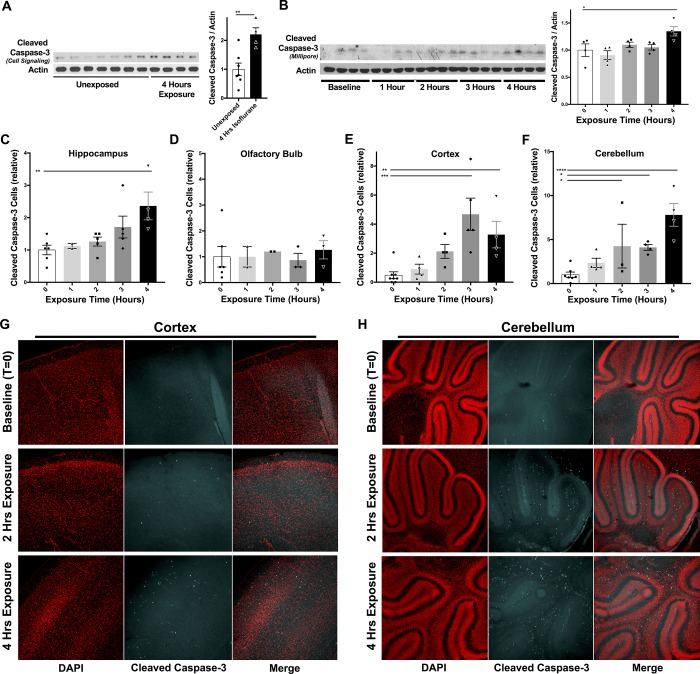
Anesthesia induced apoptosis in P7 neonatal mice.(A) Western blot probing for cleaved caspase-3 in brain lysates from control P7 mice (unexposed) and P7 mice exposed to 1.5% isoflurane for 4 hours. **p<0.005, pair-wise t-test. n = 7 and 4 for baseline and exposed, respectively. (B) Western blot probing for cleaved caspase-3 in brain lysates from P7 mice exposed to 1.5% isoflurane for 0 to 4 hours. ANOVA p-value<0.0008; **p<0.005, post-hoc pair-wise t-test. n = 4 at each timepoint. (C-F) Quantification of cleaved caspase-3 positive cells in the hippocampus (C), olfactory bulb (D), cortex (E), and cerebellum (F) of P7 neonatal mice exposed to 1.5% isoflurane for 0–4 hours. One-way ANOVA: hippocampus: *p<0.02; olfactory bulb: non-significant; cortex ***p = 0.0006; cerebellum *** p = 0.0007. In each panel *p<0.05, **p<0.005, ***p<0.0005 in post-hoc pair-wise t-tests. Error bars represent SEM. (G-H) Representative confocal images of immunofluorescent staining for cleaved caspase-3 in the cortex (G) or cerebellum (H) of animals exposed to 1.5% isoflurane for 0, 2, or 4 hours. The red channel represents DAPI, a fluorescent DNA binding molecule. The cyan channel represents the anti-cleaved Caspase-3 antibody directly conjugated to AlexaFluor647. Additional details regarding replicate numbers in cleaved caspase-3 staining in Methods.